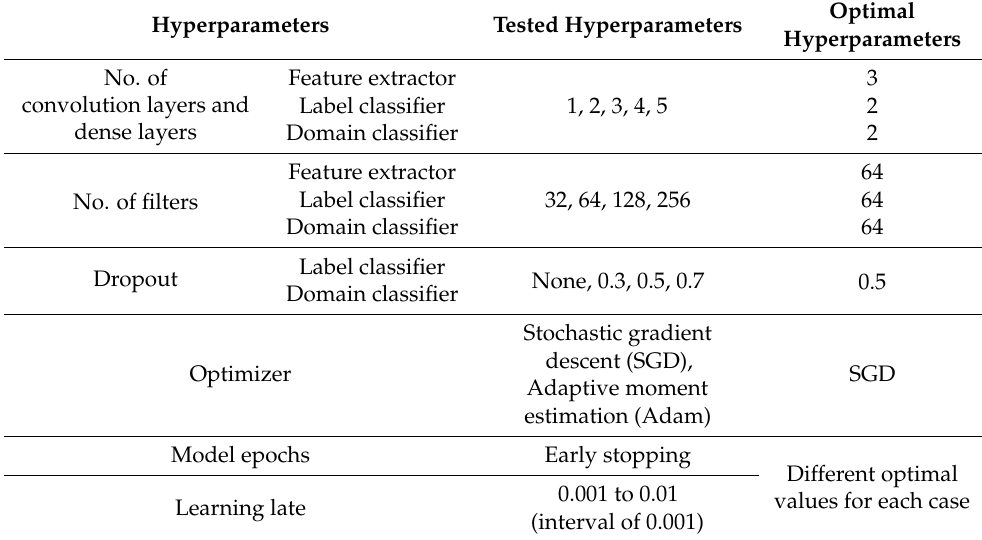
Table 3. A list of the tested and optimal hyperparameter